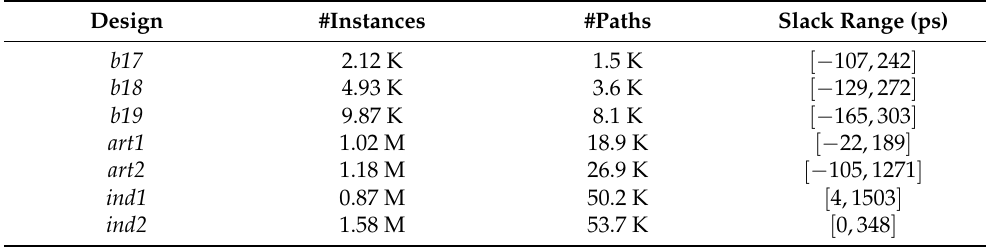
Table 3. Detailed information on